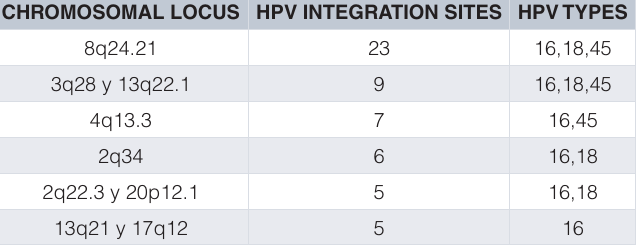
Table 2. Chromosomal loci with the highest numbers of HPV integration sites 1 .